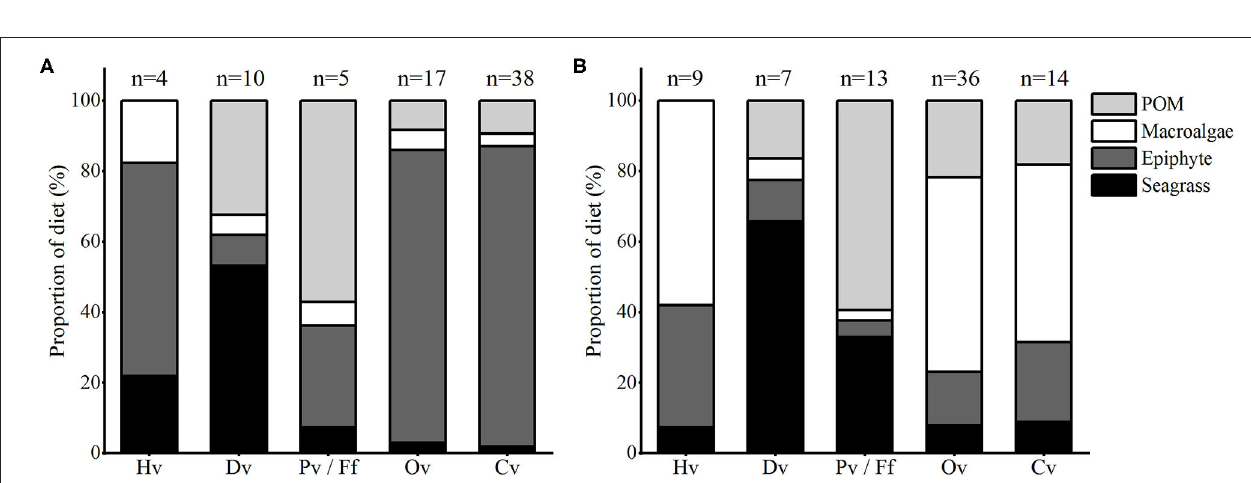
FIGURE 3 | Plots of δ 13 C and δ 15 N values (mean ± SE) for consumers and food sources in (A) summer and (B) winter in Xincun bay. Sample sizes of consumers and food sources were 74 and 5 in summer, and 79 and 5 in winter, respectively. Pv represents planktivores, and Ff represents filter feeders. Legends for food sources and consumers are given in Table 2 and Supplementary Table 5 , respectively.